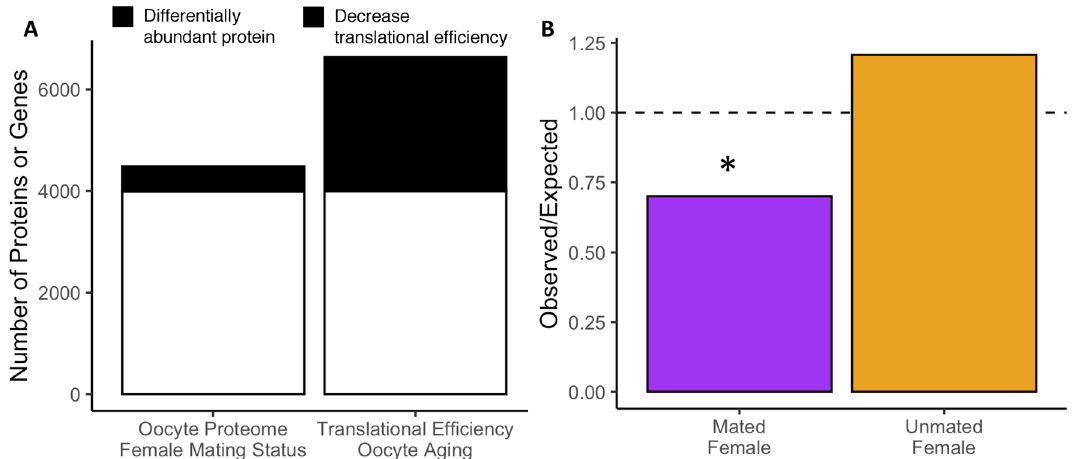
Figure 3. Oocyte proteome composition differences are distinct from age-dependent changes. ( A ) Stacked bar chart displaying the proportions of oocyte proteins exhibiting mating-dependent changes in abundance and genes exhibiting age-dependent decreases in translational efficiency. ( B ) Observed versus expected overlap of proteins exhibiting age-dependent reductions in translational efficiency and proteins that change in abundance between oocytes from mated and unmated females (*p <